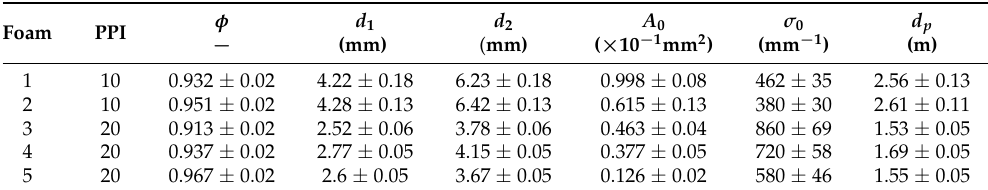
Table 1. Properties of studied foam samples, determined through a µ CT scan with a voxel size of 8.5 µ m [56]. All reported foam samples were made in-house.